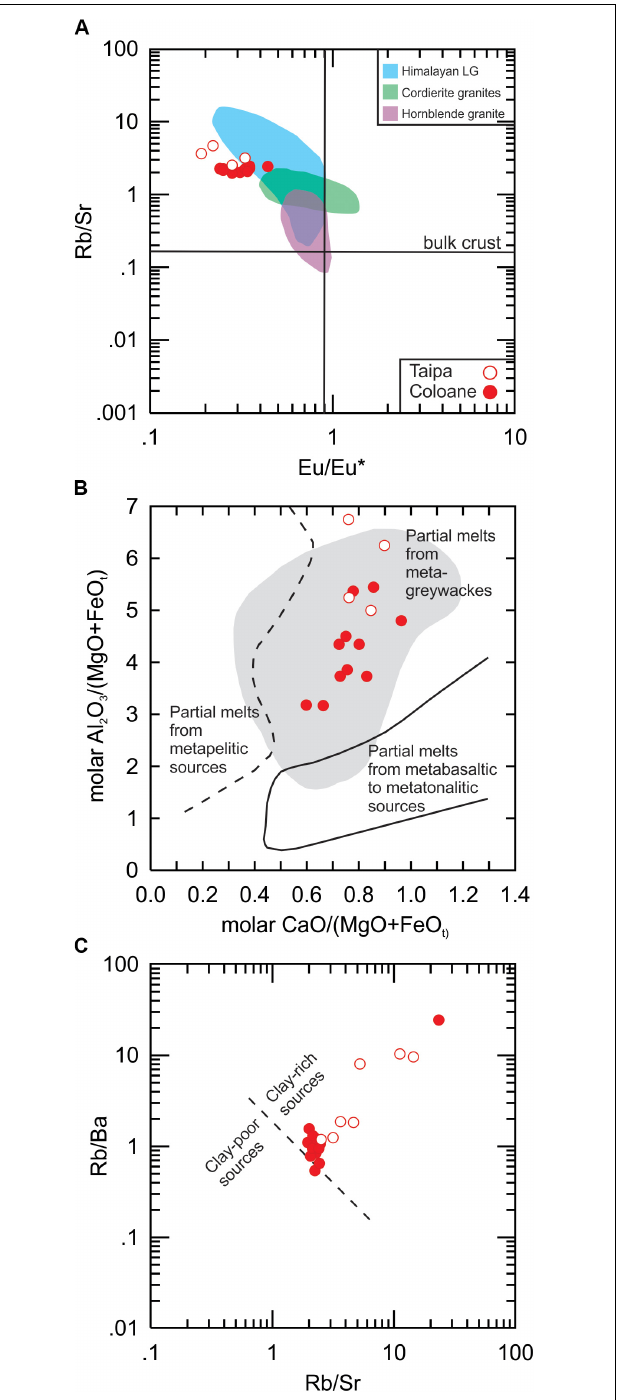
FIGURE 10 | (A) Logarithmic Sr/Rb vs. Eu/Eu* plot of the Taipa and Coloane leucogranites with ranges of hornblende granites, Himalayan leucogranites, and cordierite granites from Kemp and Hawkesworth (2003). (B) Molar Al 2 O 3 /(MgO + FeOt) vs. molar CaO/(MgO + FeOt) with the fields outlining compositions of melts derived by dehydration melting of different bulk compositions (Altherr et al., 2000). (C) Post-collisional strongly peraluminous granites divided into clay-poor and clay-rich sources on the basis of Rb/Ba and Rb/Sr (Sylvester, 1998).